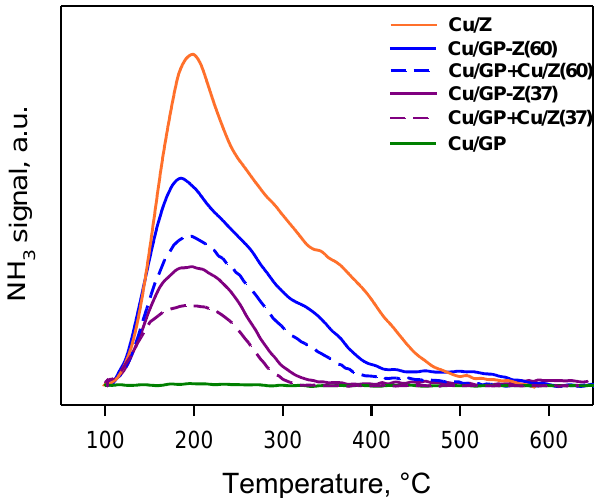
Figure 5. NH 3 -TPD profiles for pure Cu/GP and composite Cu/GP – Z(x) monoliths and reference pure Cu/Z, or in mechanical mixtures with pure Cu/GP with identical nominal composition as monoliths.